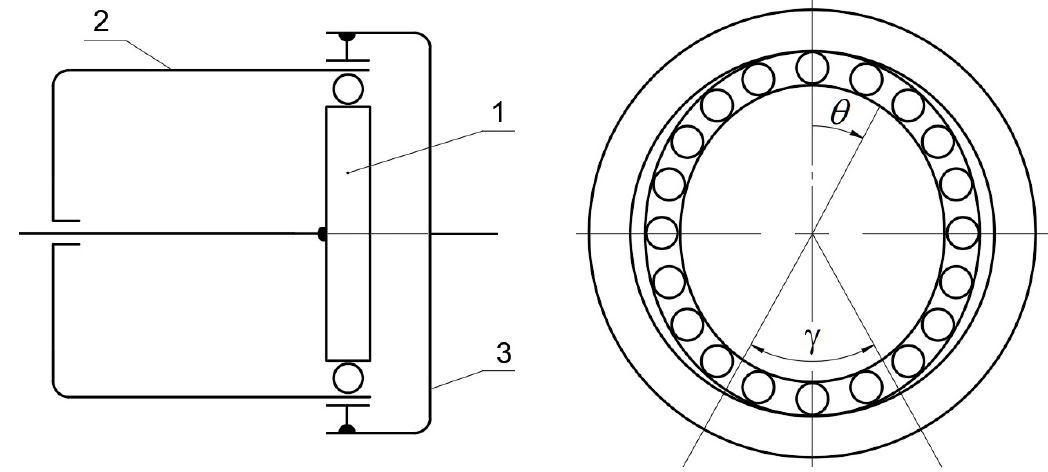
Figure 1. Scheme of harmonic drive: (1) flexspline, (2) circular spline, (3) wave